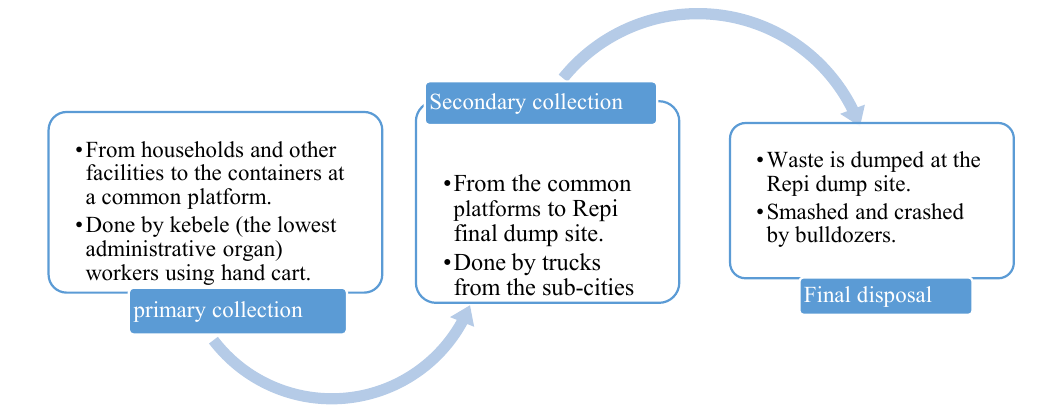
Figure 5. The formal waste management Figure 5. The Formal Waste Management Process